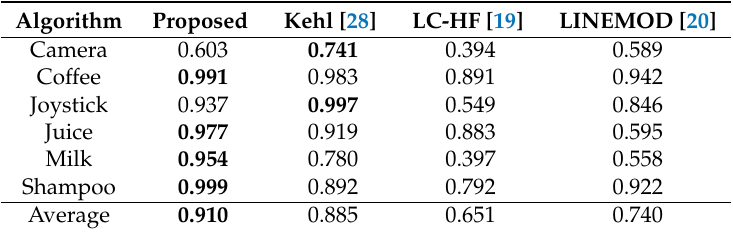
Table 2. F1-score of the algorithms on the Tejani dataset of [19].